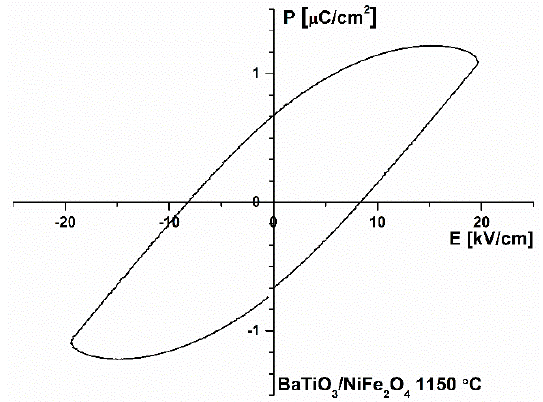
Figure 11. Hysteresis loop of BaTiO 3 /NiFe 2 O 4 sintered at 1150 °C at 20 kV/cm field.